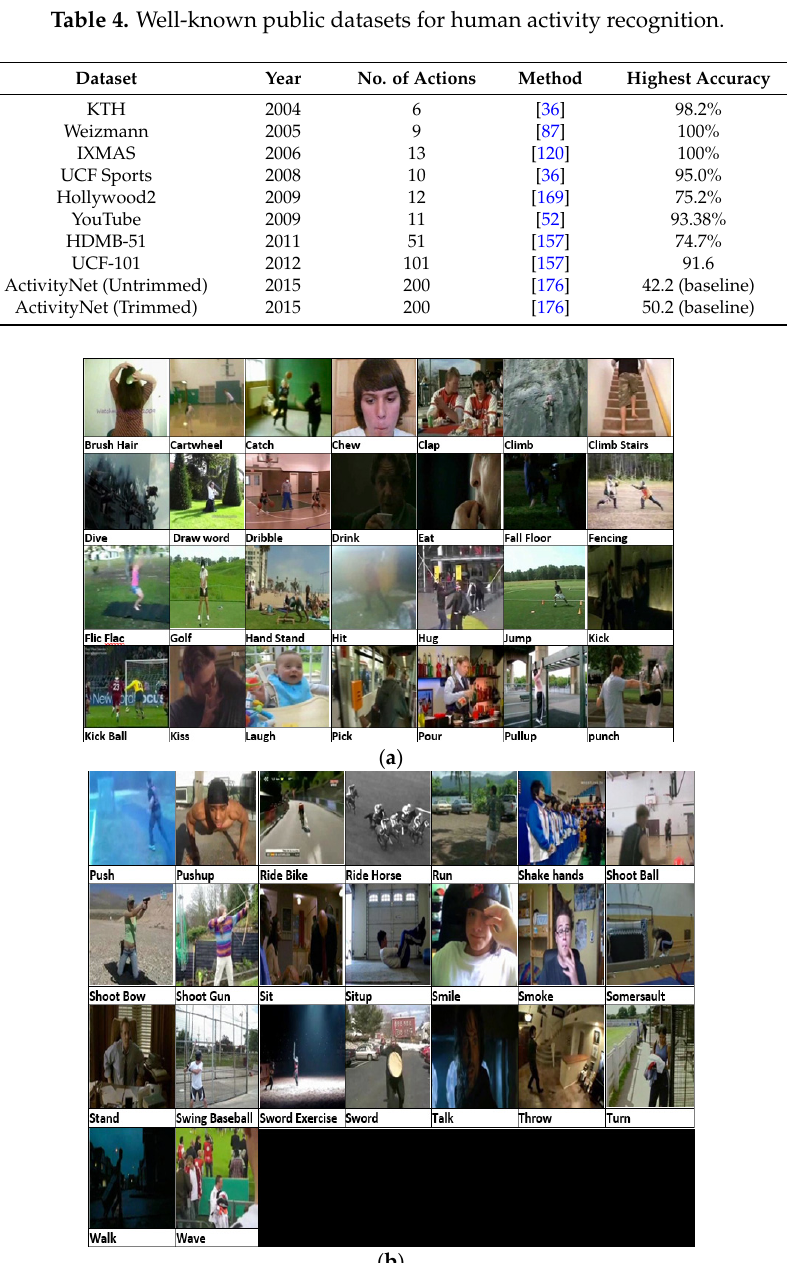
Figure 14. ( a ) Exemplar frames for action 1–28 from HMDB (Human Motion Database) ‐ 51 action dataset; ( b ) Exemplar frames for action 29–51 from HMDB ‐ 51 action dataset. Table 4. Well ‐ known public datasets for human activity